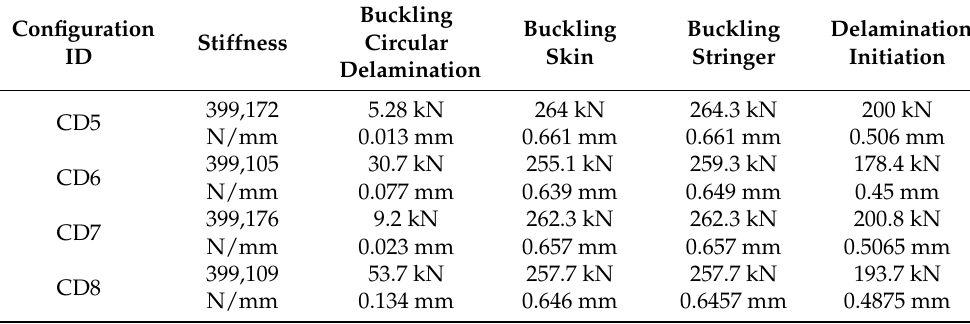
Table 4. Buckling loads and displacements for CD5 –CD8 configurations.